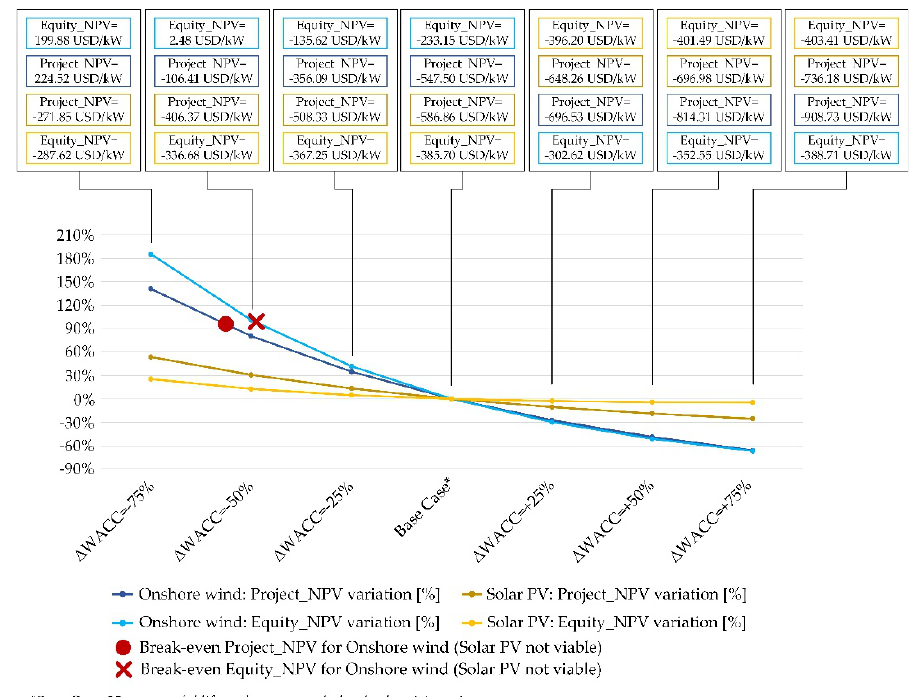
Figure 5. Project and equity NPV percentage variation with WACC percentage variation for the Danish case. Source: self ‐elaboration.